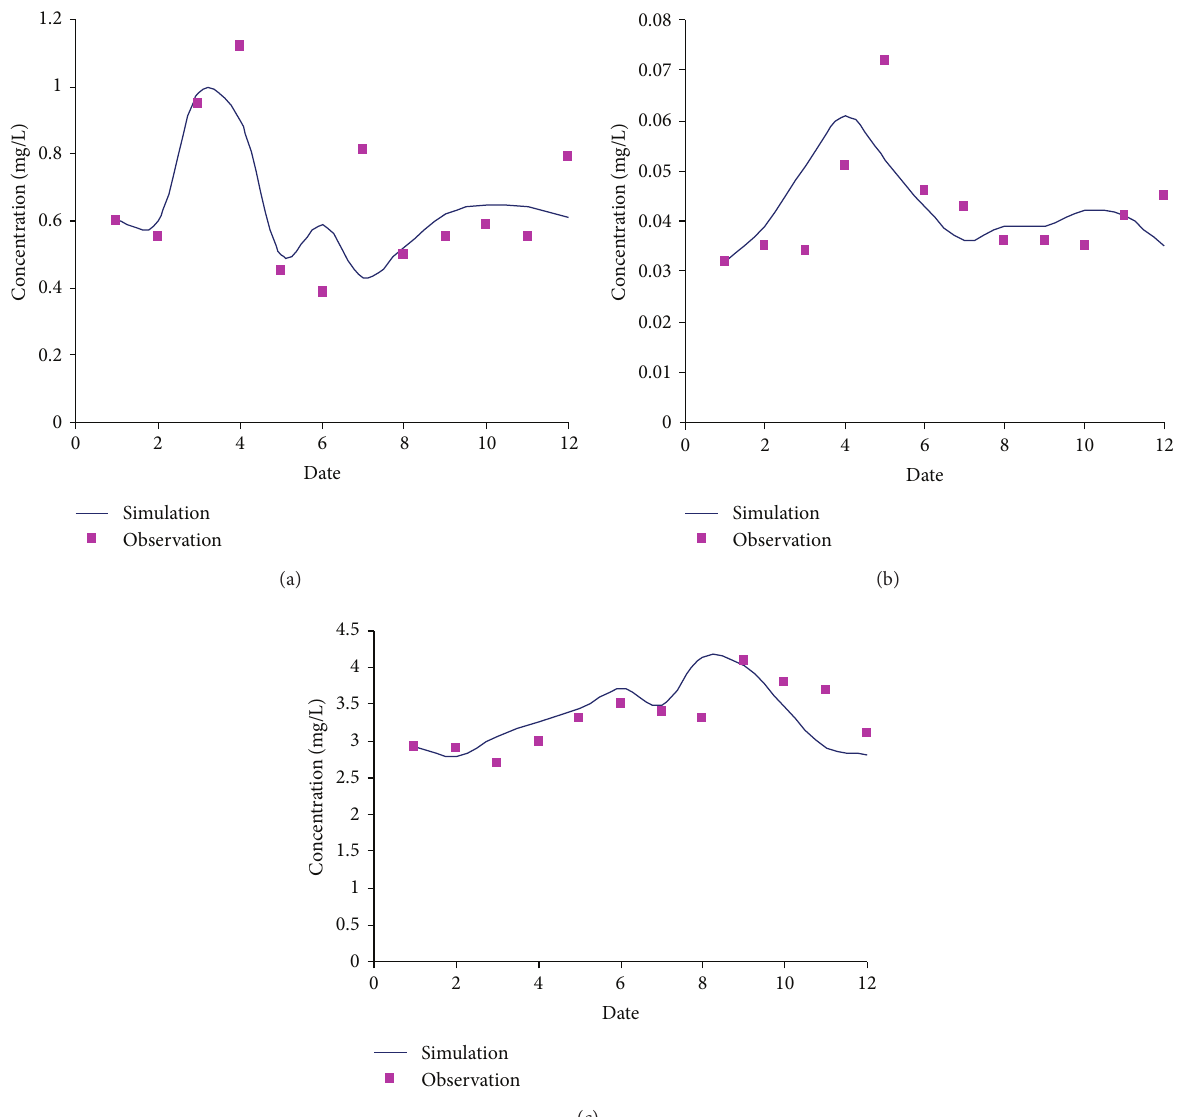
Figure 5: Comparison of simulation with observation in Daguanyi